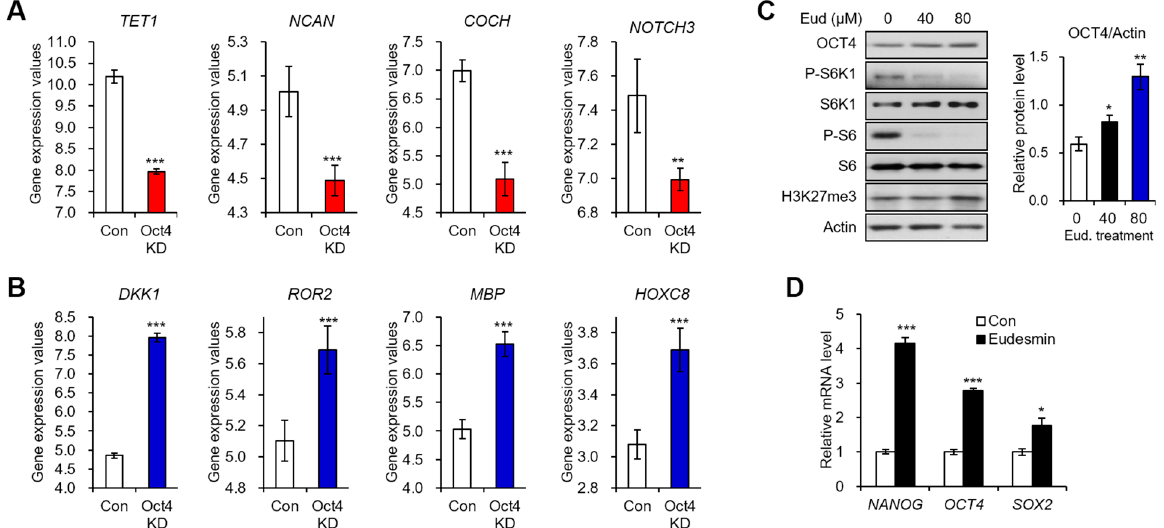
Figure 5. Eudesmin treatment promotes the expression of pluripotency marker genes. ( A ) Gene expression values of representative cluster 1 genes ( TET1 , NCAN , COCH , and NOTCH3 ) in Oct4-depleted embryonic stem cells (GDS1824). ( B ) Gene expression values of representative cluster 2 genes ( DKK1 , ROR2 , MBP , and HOXC8 ) in Oct4-depleted embryonic stem cells (GDS1824). ( C ) Immunoblot analysis of H7 embryonic stem cells treated with or without eudesmin (40, 80 µ M) for 24 h. ( D ) The mRNA levels of NANOG , OCT4 , and SOX2 genes in H7 embryonic stem cells treated with or without eudesmin (80 µ M) for 24 h. Data represent means ± SEM for n = 3. * p < 0.05, ** p < 0.01, *** p <